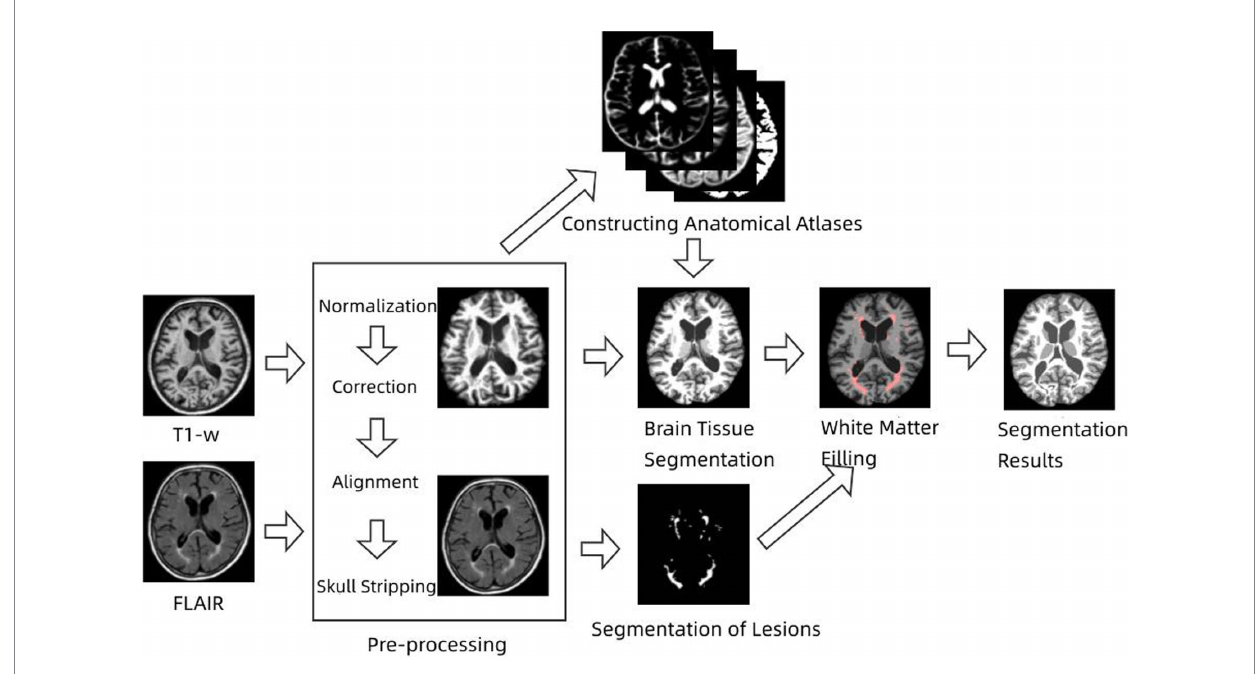
FIGURE 3 Flow chart of energy minimization algorithm based on lesion filling and anatomical